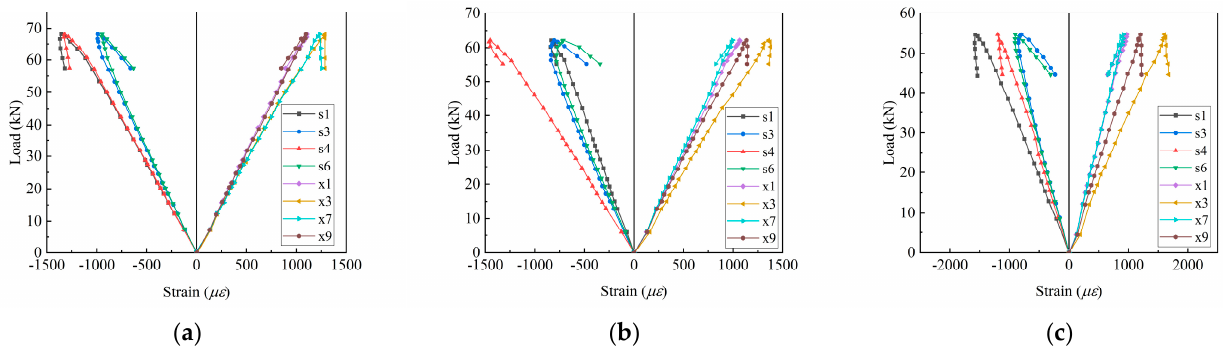
Figure 14. Load–strain curves of the web: ( a ) Test beam A01; ( b ) Test beam A11; ( c ) Test beam A23.